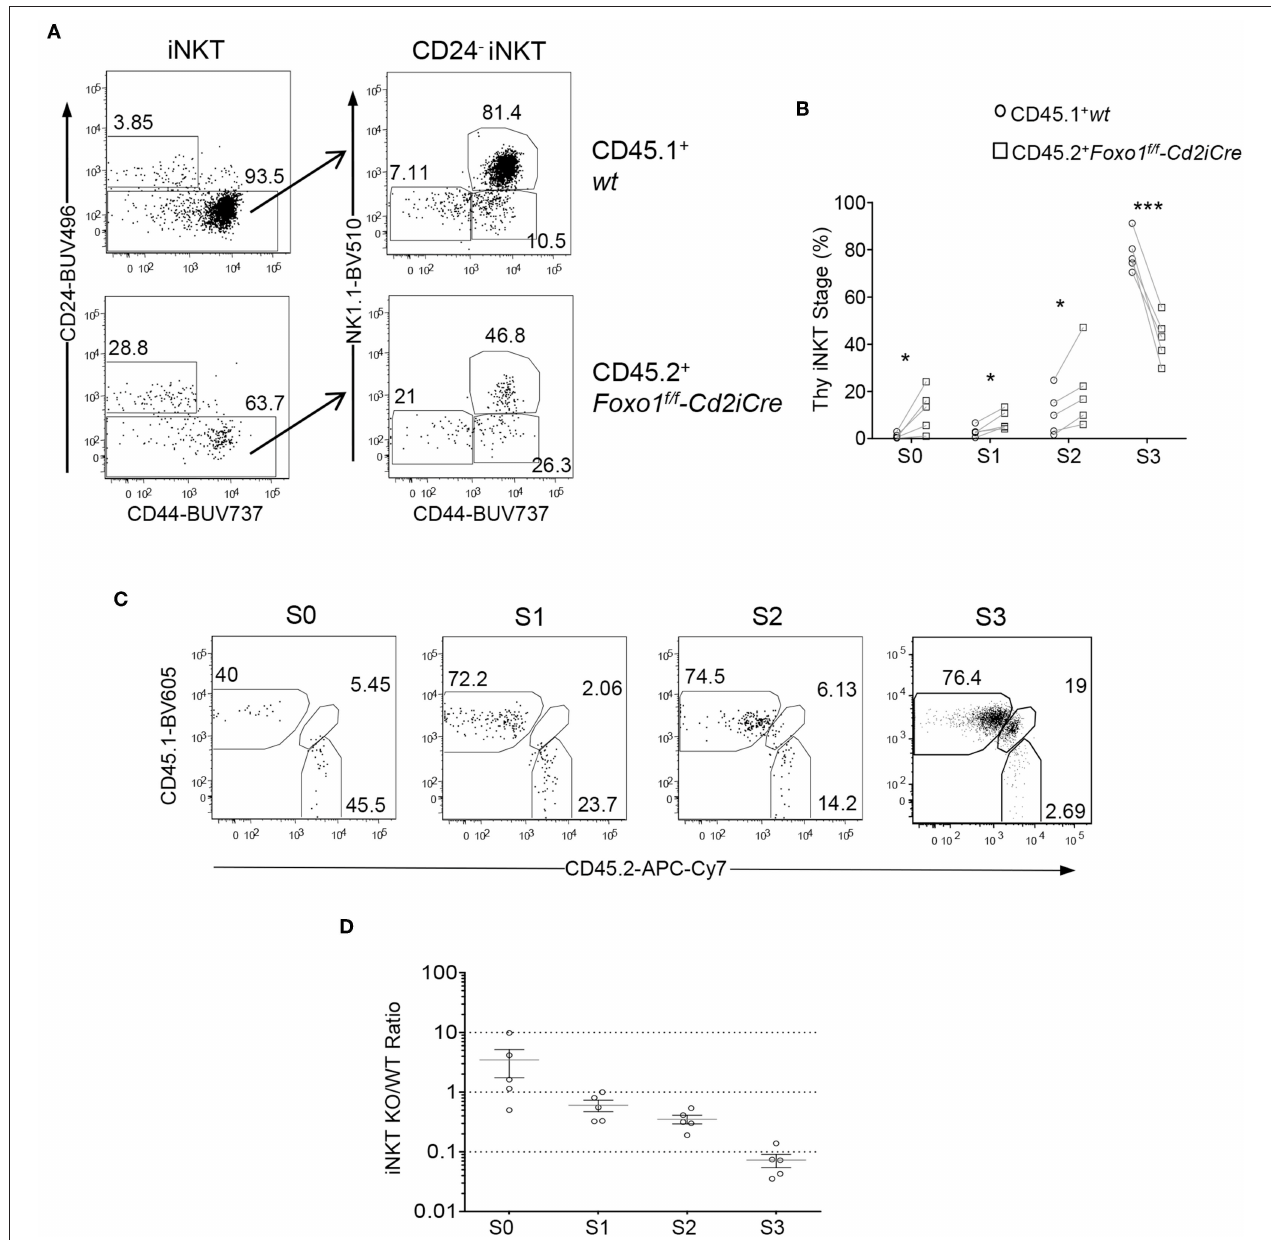
FIGURE 4 | Intrinsic control of late stage i NKT cell development by Foxo1. Thymocytes and splenocytes and liver MNCs from mixed BM chimeric mice as described in Figure 2 were similarly analyzed. (A) Representative FACS plots showing CD24 and CD44 staining in live gated Lin-CD45.1 + WT and CD45.2 + Foxo1KO thymic i NKT cells (left panels) and CD44 and NK1.1 staining in the CD24 − population of i NKT cells. (B) Scatter plots showing percentages of i NKT cell developmental stages. (C) Representative FACS plots showing CD45.1 and CD45.2 staining on stage 0–3 i NKT cells. (D) Scatter plots showing CD45.2/CD45.1 ratios of individual i NKT cell developmental stages. Connecting lines indicate CD45.1 WT and CD45.2 Foxo1KO i NKT cells in individual mice. One chimeric mouse was examined in each experiment. * p < 0.05; *** p < 0.001 determined by two-tail pair-wised Student t -test.